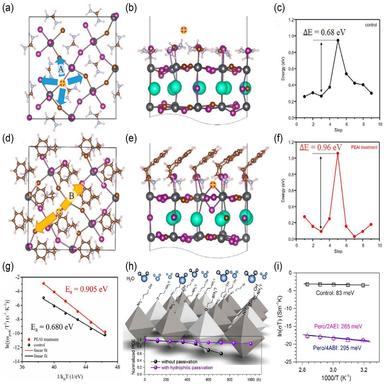
Top view (a and d), side view (b and e), and energy barrier (c and f) of the diffusion of the I interstitial on perovskite surface without (a–c) and with PEAI treatment (d– f). (g) Arrhenius plots of the characteristic transition frequencies derived from the admittance spectra . Copyright 2020, American Chemical Society. (h) Schematic of 4ABI and 2AEI passivating perovskites. (i) Temperature-dependent conductivity of perovskite devices before and after post-treatment with 4ABI and 2AEI. Copyr